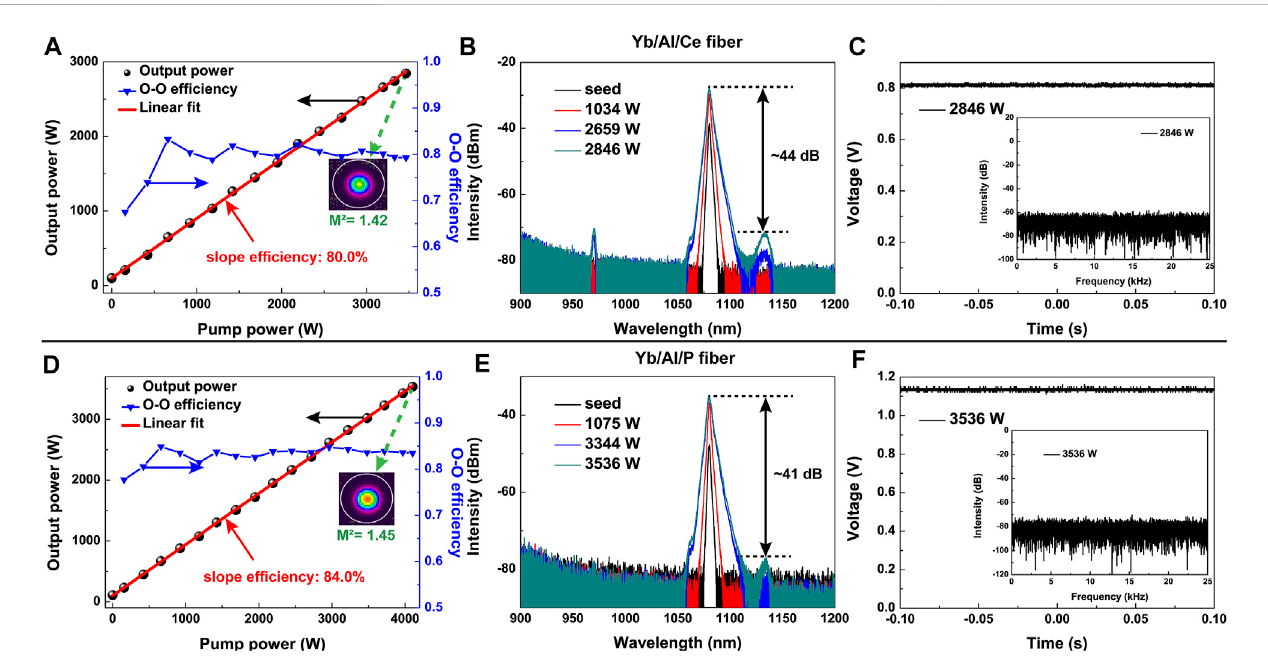
FIGURE 9 Laserperformancesinbidirectionalpumpingampli fi er.Yb/Al/Ce fi ber: (A) outputpowerandO-Oef fi ciencydependenceonthepumppower; (B) optical spectra at several output powers; (C) time- and frequency-domain signals. Yb/Al/P fi ber: (D) output power and O-O ef fi ciency dependence on the pump power; (E) optical spectra at several output powers; (F) time- and frequency-domain signals.